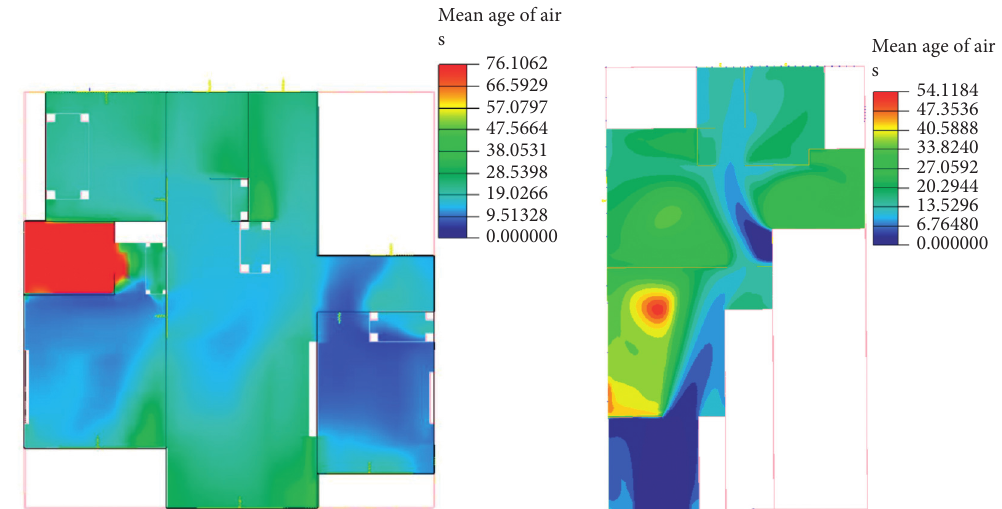
Figure 12: Air age distribution of two house types A and B under condition